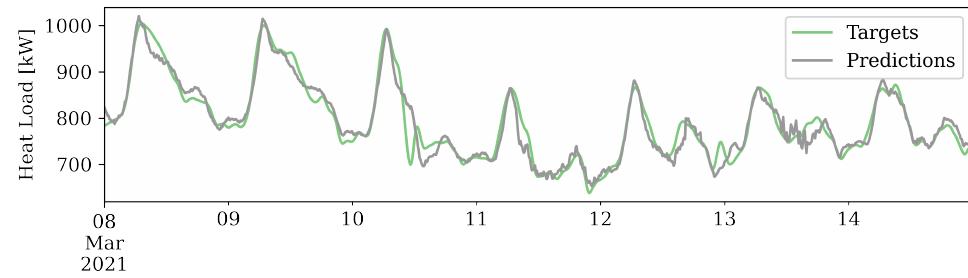
Figure A2. The smallest MAPE score of 1.9% is produced by the +1-model, the model with the shortest forecast horizon. The predicted values by the +1-model (predictions) and the real observations for the same period (targets) are displayed for that specific week in March